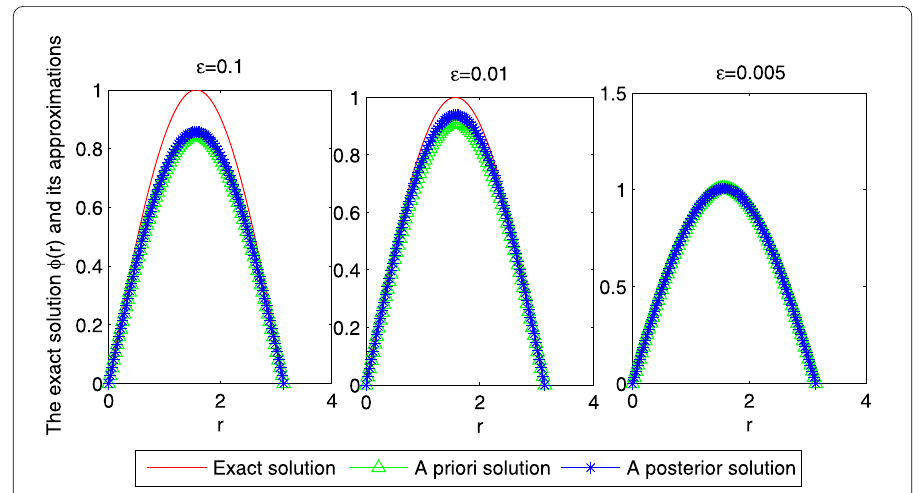
Figure 1 The comparison of numerical effects between the exact solution and its regularized solution for Example